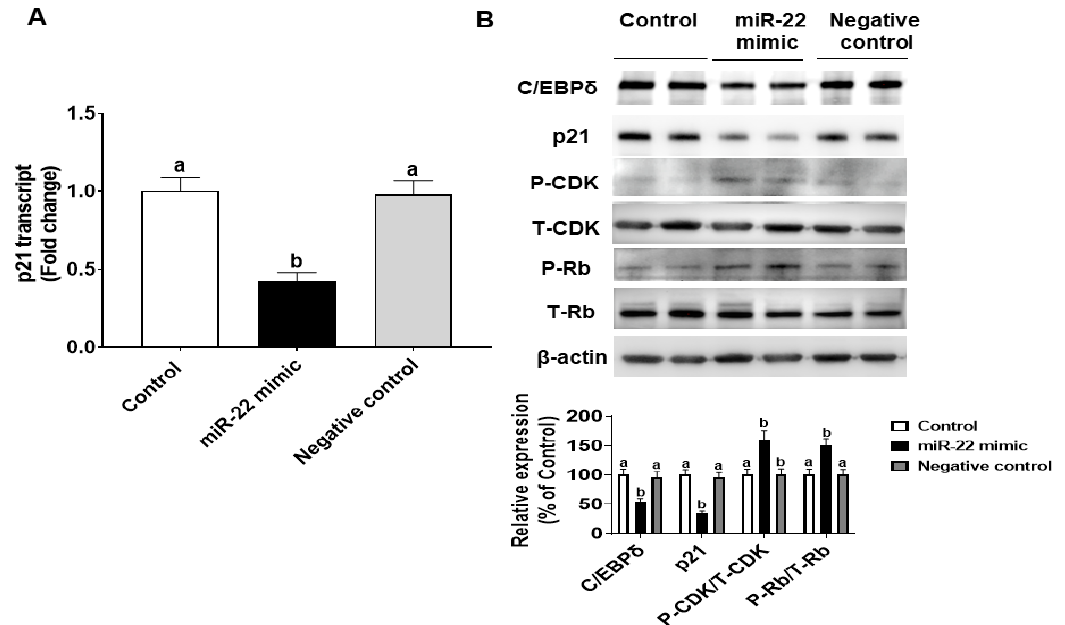
Figure 7. Effects of miR ‐ 22 on the protein level of a downstream target of C/EBP δ , p21. After HIEC cells were transfected with miR ‐ 22, the RNA level of p21 was evaluated by qRT ‐ PCR ( A , B ) Protein levels of p21, phospho ‐ CDK2 (P ‐ CDK2), total ‐ CDK2 (T ‐ CDK2), phosphor ‐ Rb (P ‐ Rb), and total ‐ Rb (T ‐ Rb) were evaluated by immunoblotting, respectively. n = 5. Values are shown as mean ± SD, relative to the control (set to 1). Bars without a common letter are significantly different ( p < 0.05).